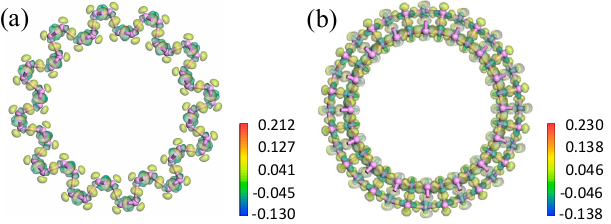
Figure 8. Electron density difference for aPNT and zPNT with a radius of 7.3 Å. The profiles of the electron density difference vertical to the central axe of ( a ) aPNT; and ( b ) zPNT. The attached rulers show the transferred charge corresponding to the colors.